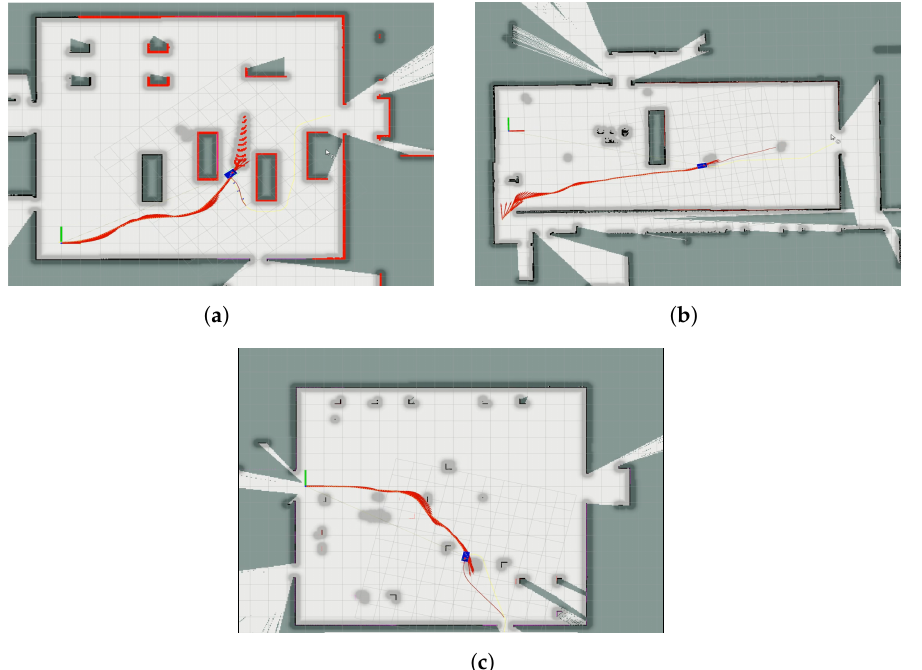
Figure 2. Illustrative examples of weaknesses detected while running the classical TEB planner inside the 9 stages. The blue rectangle represents the robot, red arrow represents the path, the grey shadow represents the obstacles, red arcs represent the contours of the obstacles detected by the ROS packages. ( a ) Stage 1, the planner cannot avoid collision when passing through narrow corridors; ( b ) Stage 2, planner passed through obstacle instead of slowing or detouring; ( c ) Stage 3, planner crosses the obstacle’s frontal